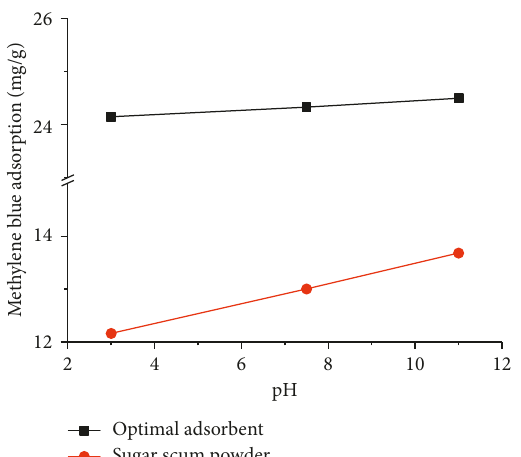
Figure 7: Effect of pH on the amount of adsorption of methylene blue (adsorbent dose � 4 g · L − 1 ; [MB] � 100mg · L − 1 ; T � 25 ° C).